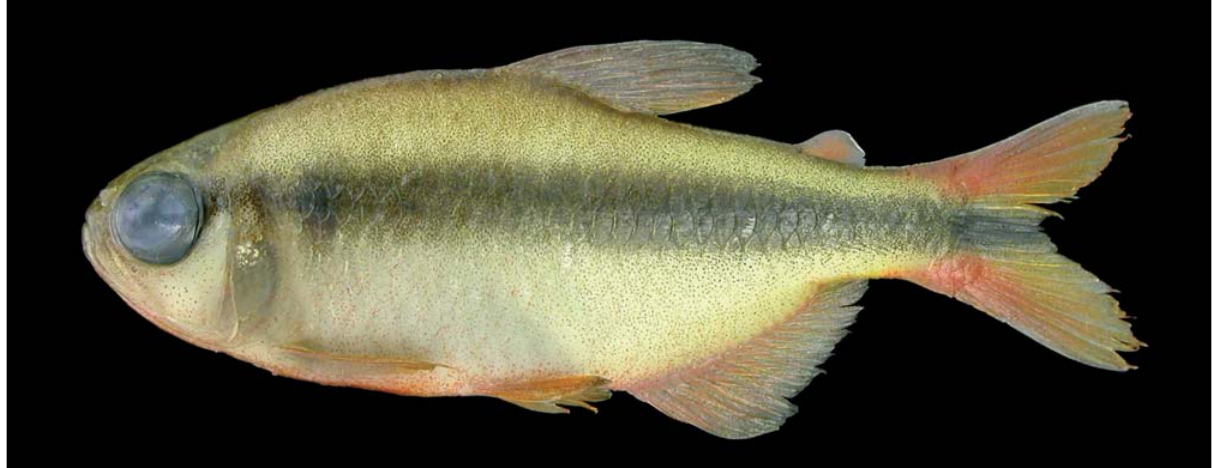
Fig. 3. Hyphessobrycon melanostichos , MCP 38396, paratype, 33.8 mm SL, male, color just after